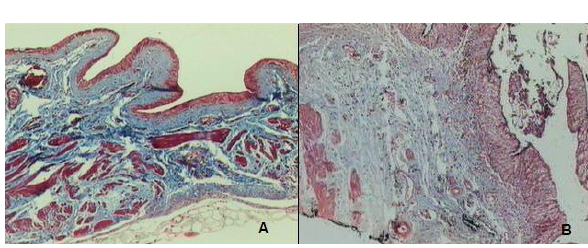
FIGURA 7 - Fibras colágenas em grande quantidade em animal do SGP7 (A) e poucas fibras colágenas em animal do SGC7